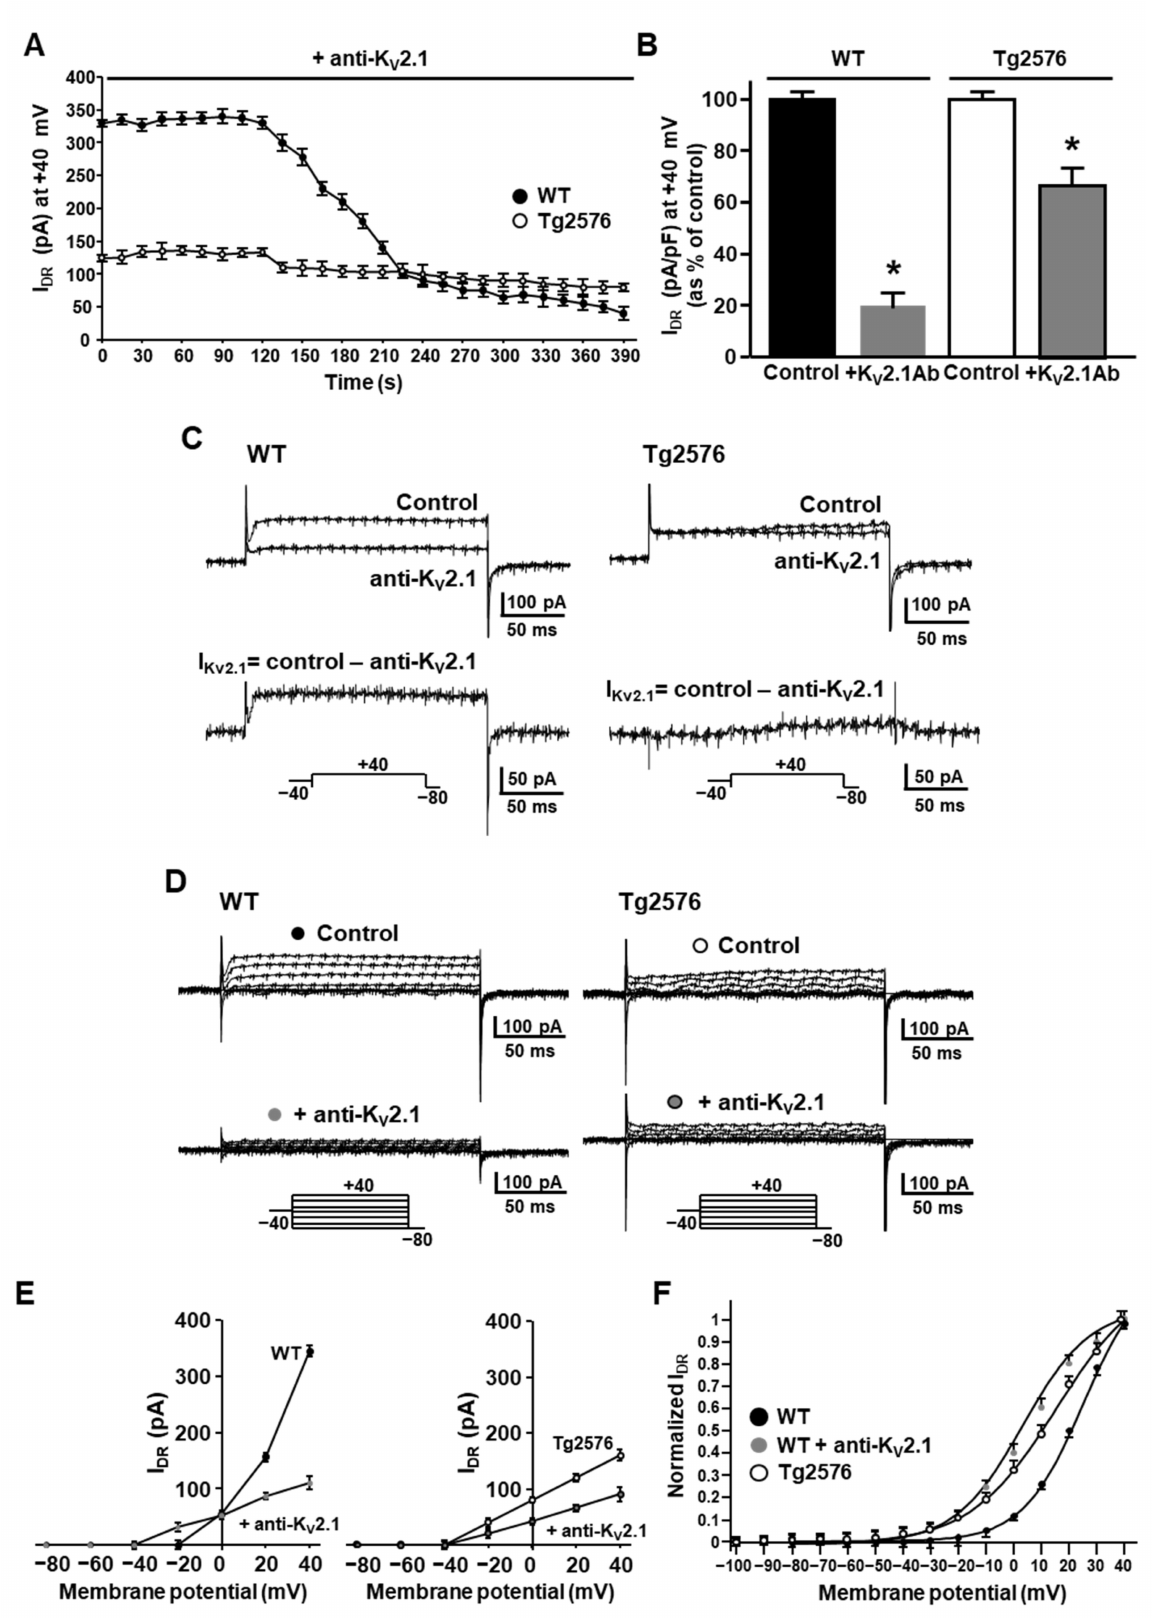
Figure 3. Effect of the intracellular diffusion of the anti-K V 2.1 monoclonal antibody on I DR recorded in the WT and Tg2576 primary hippocampal neurons. ( A ) Time-dependent inhibitory effect of